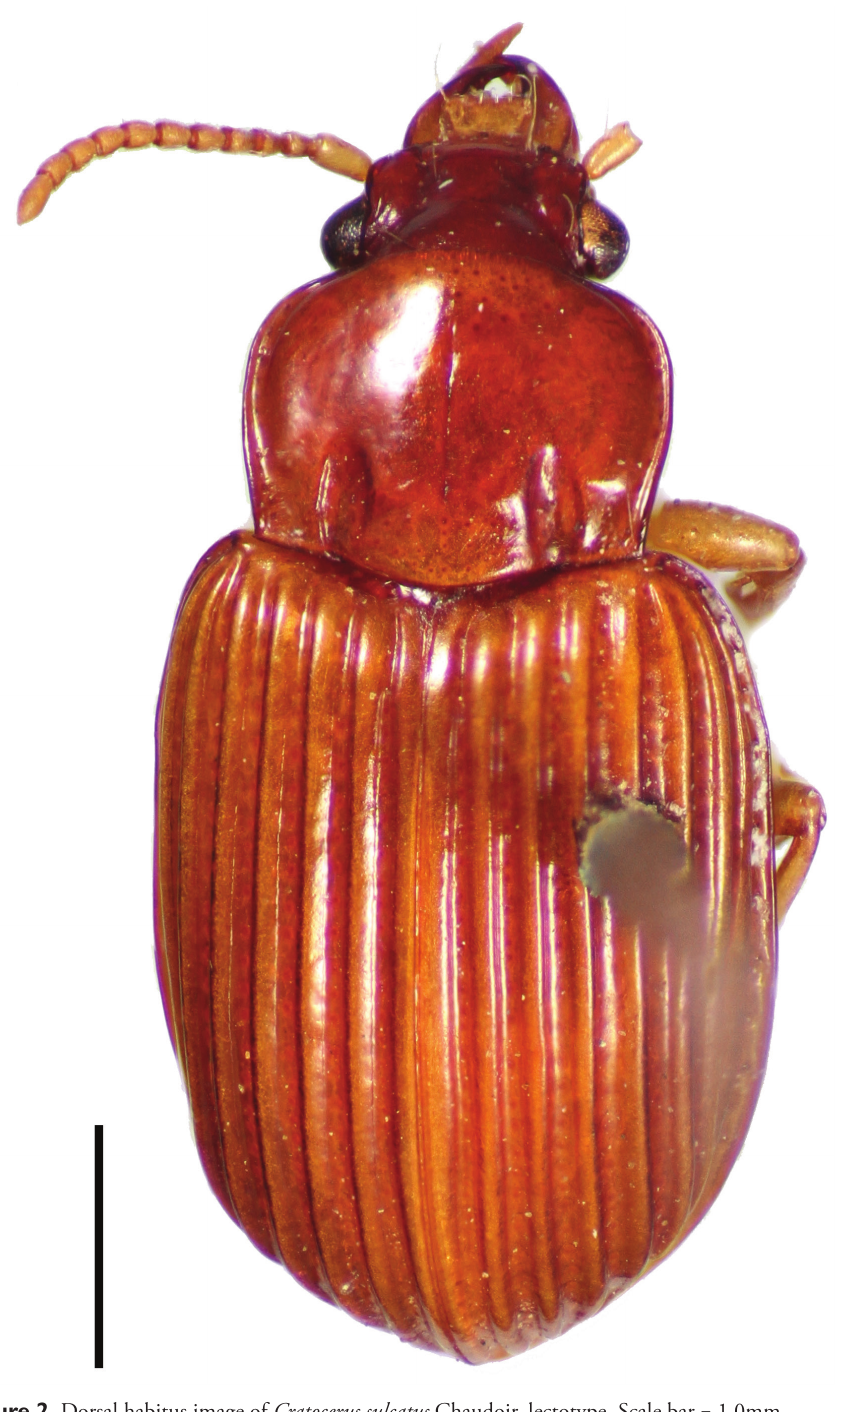
Figure 2. Dorsal habitus image of Cratocerus sulcatus Chaudoir, lectotype. Scale bar =